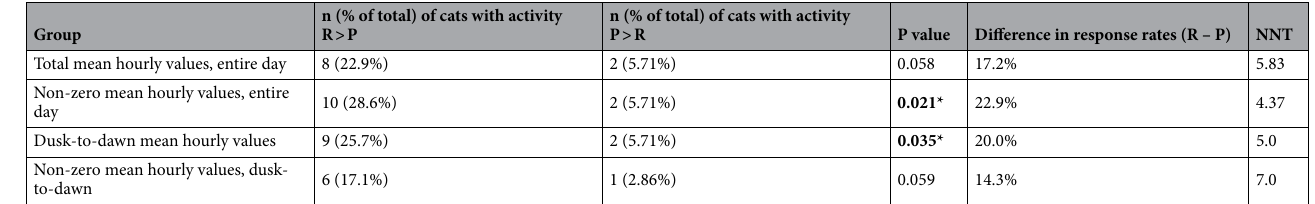
Table 5. Analysis of within-cat activity data ( n = 35), showing the number and percentage of cats in which hourly activity counts were significantly higher during either placebo (P) or robenacoxib (R) treatment for each method of partitioning the data. NNT number needed to treat. *Significance at 0.05 level, n =